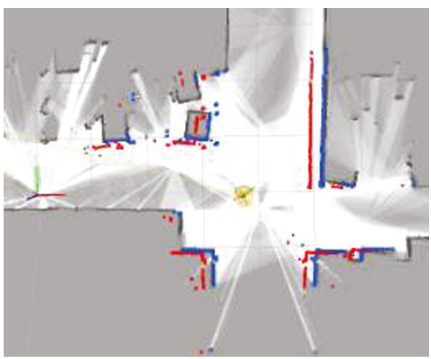
Figure 8: Experiment result of laser point cloud alignment.